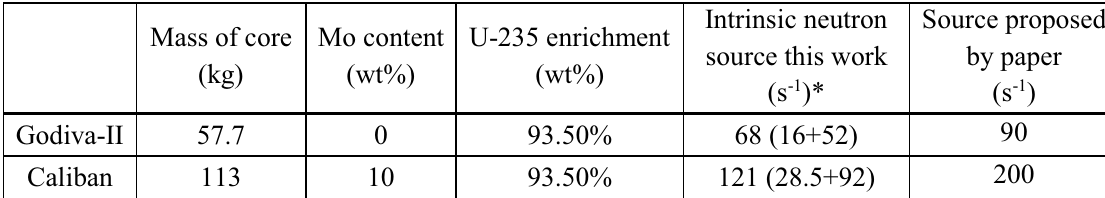
Table II. Strength of Intrinsic Neutron Source for U-235 and